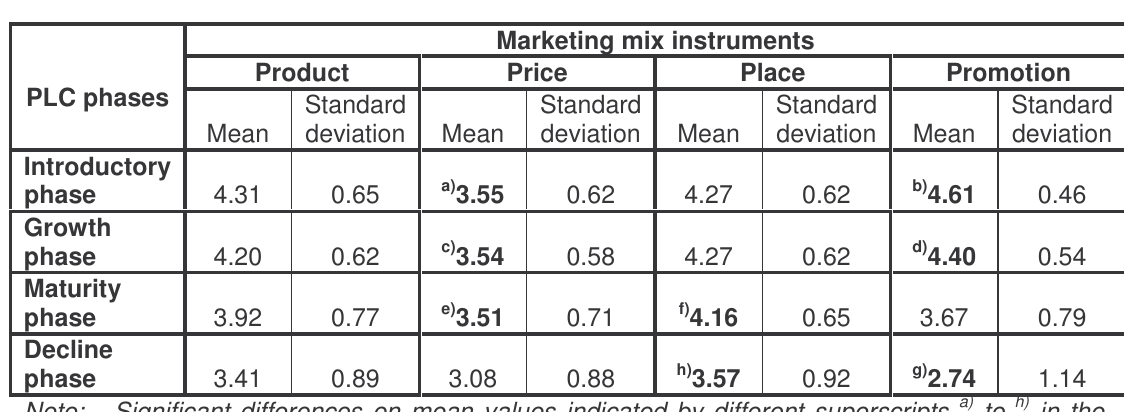
Significance test on the importance of the marketing mix instruments in the different PLC phases Marketing mix instruments Product Price Place